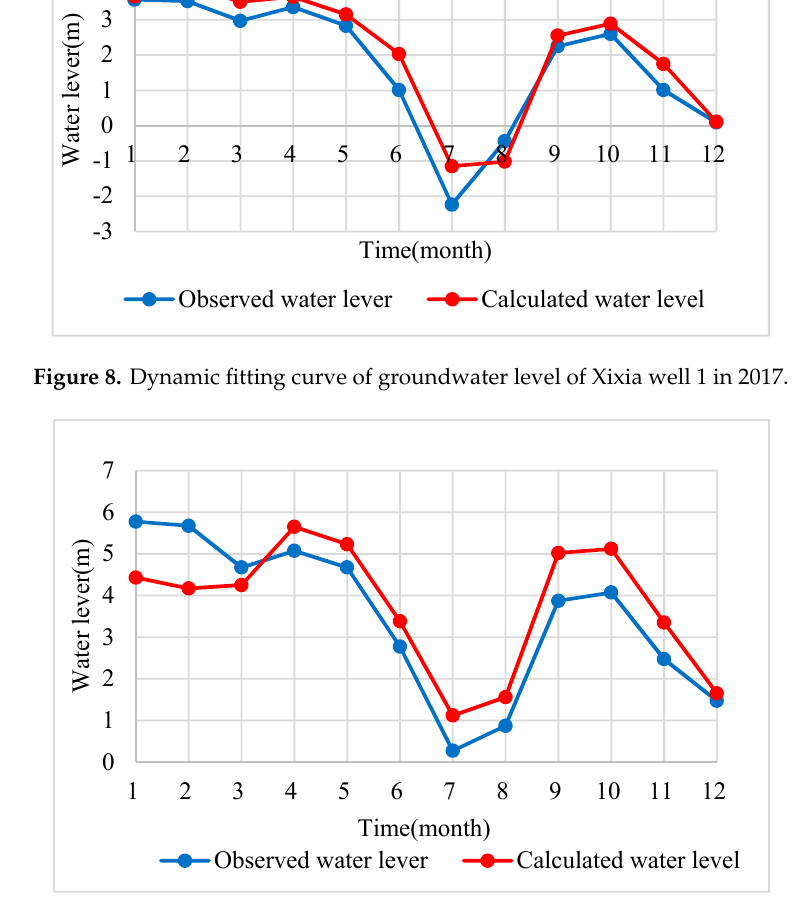
Figure 9. Dynamic fitting curve of groundwater level of Xindian well 5 in 2017.